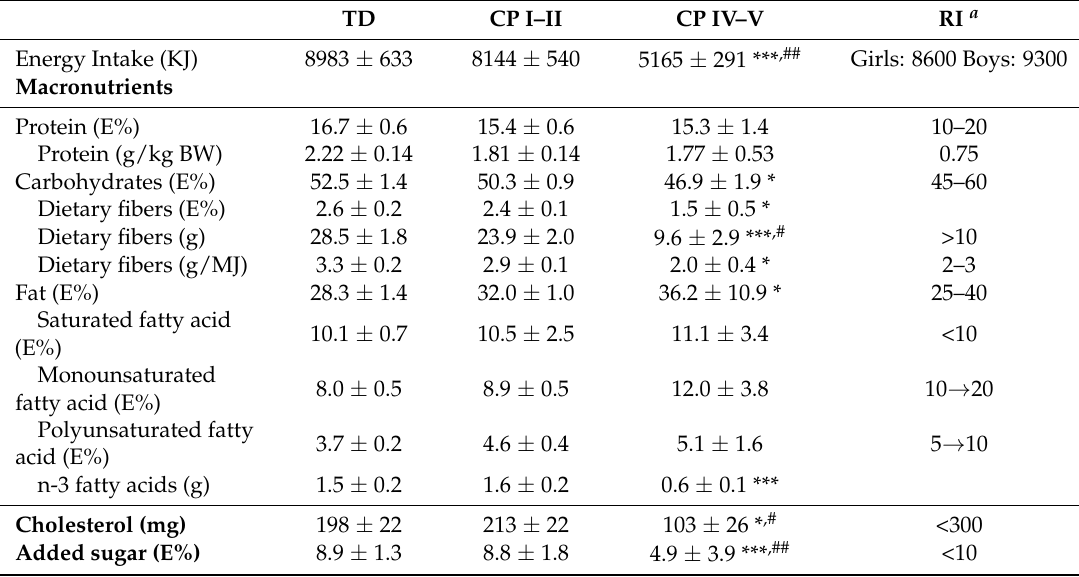
Table 3. Daily intake of energy and macronutrients.